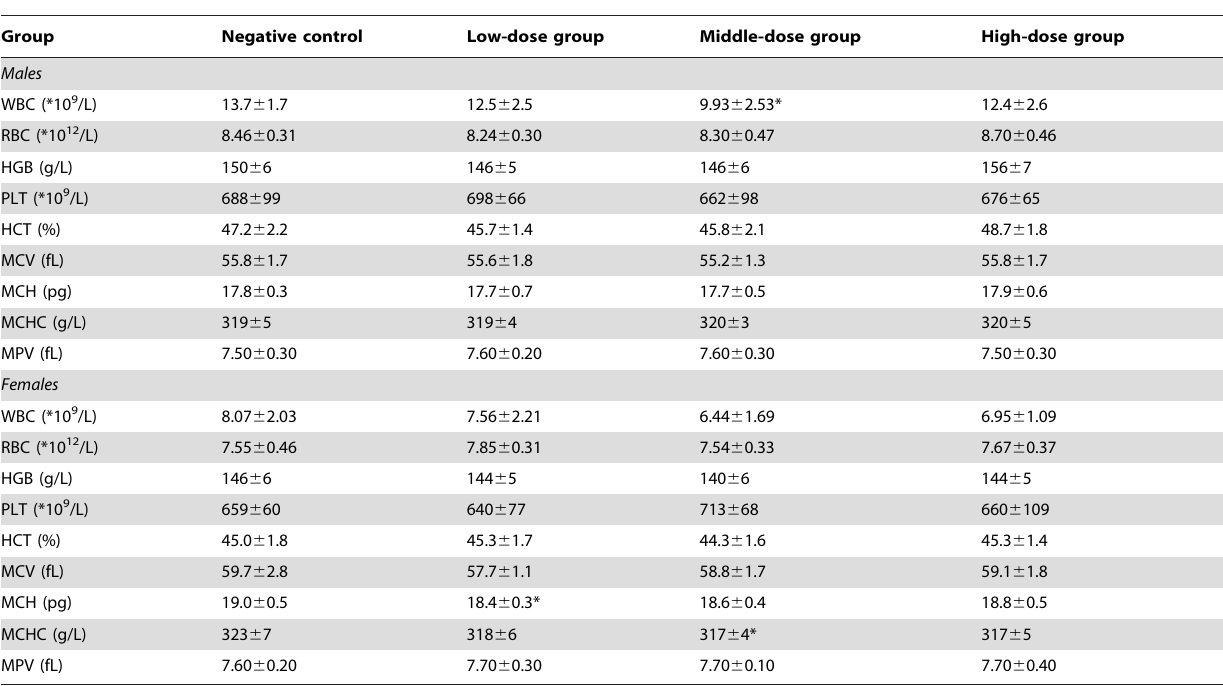
Table 7. Terminal blood hematology values of rats fed lactase for 90-days (mean 6 SD, n=10).